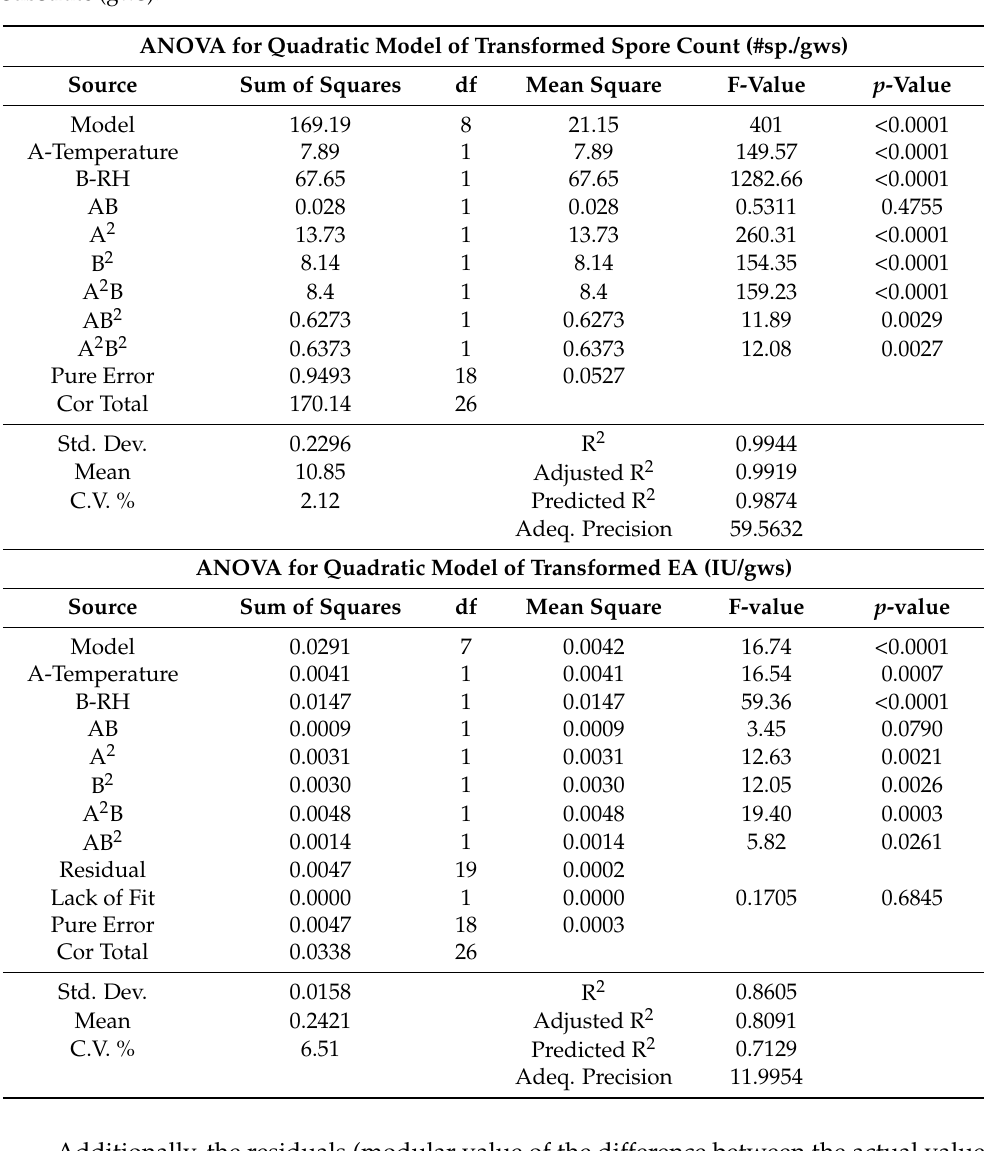
Table 3. Variance and regression analysis for 3-level factorial RSM of the transformed responses of spore count (upper) and international unit of pectinolytic enzymes (lower) activity per gram of wet substrate